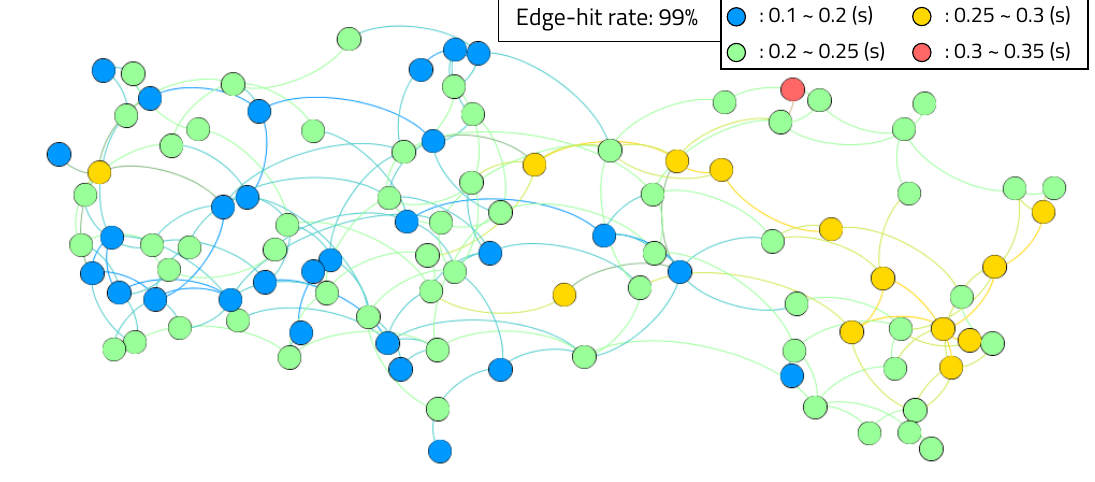
Figure 22. Large-scale simulation results with reconfiguration overheads.